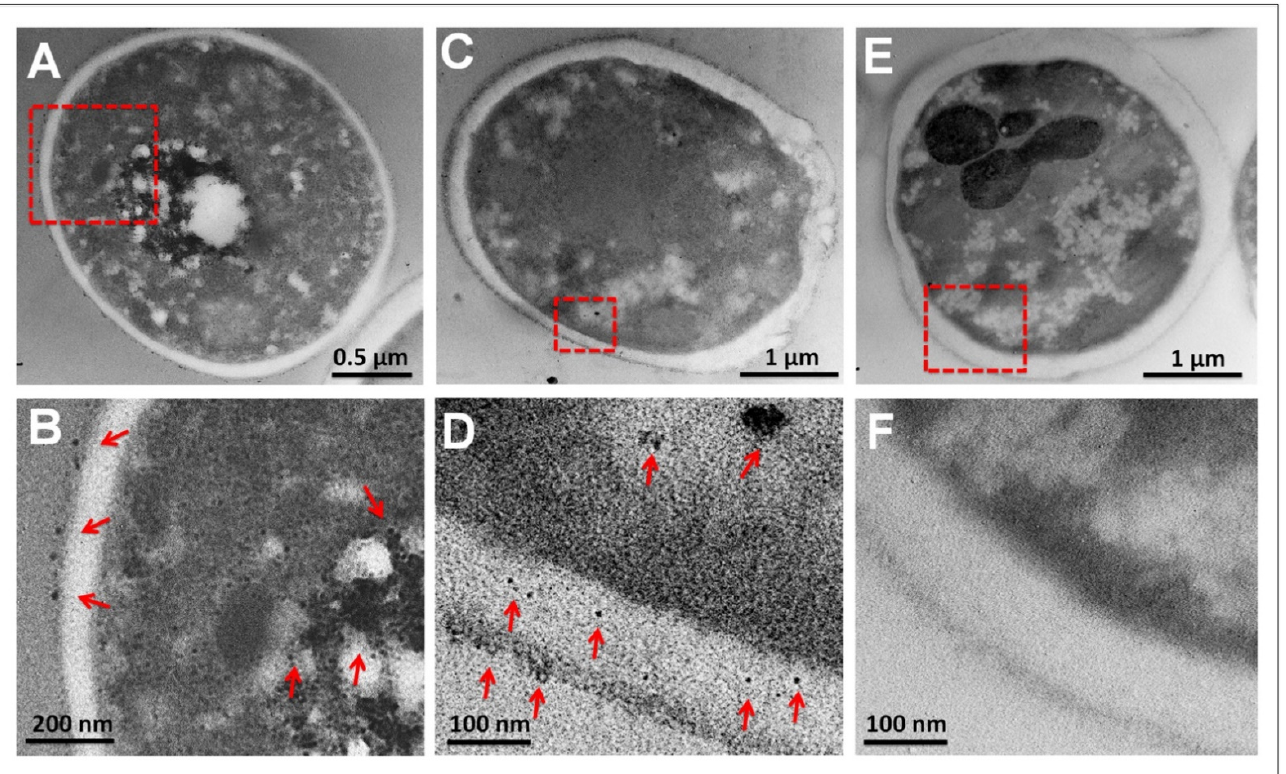
Figure 7. Micrographs of C. albicans after incubation for 24 h. ( A ) Cell exposed to CuONPs, showing a high internal accumulation of CuONPs; ( B ) amplification of marked area in ( A ) showing external and internal accumulation of nanoparticles; ( C ) cell exposed to CuONPs showing disrupted cell wall; ( D ) amplification of marked area in ( C ) showing NPs within the cell wall and cytoplasm; ( E ) cell from control culture; ( F ) amplification of marked area in ( E ). Red arrows point out CuONPs.